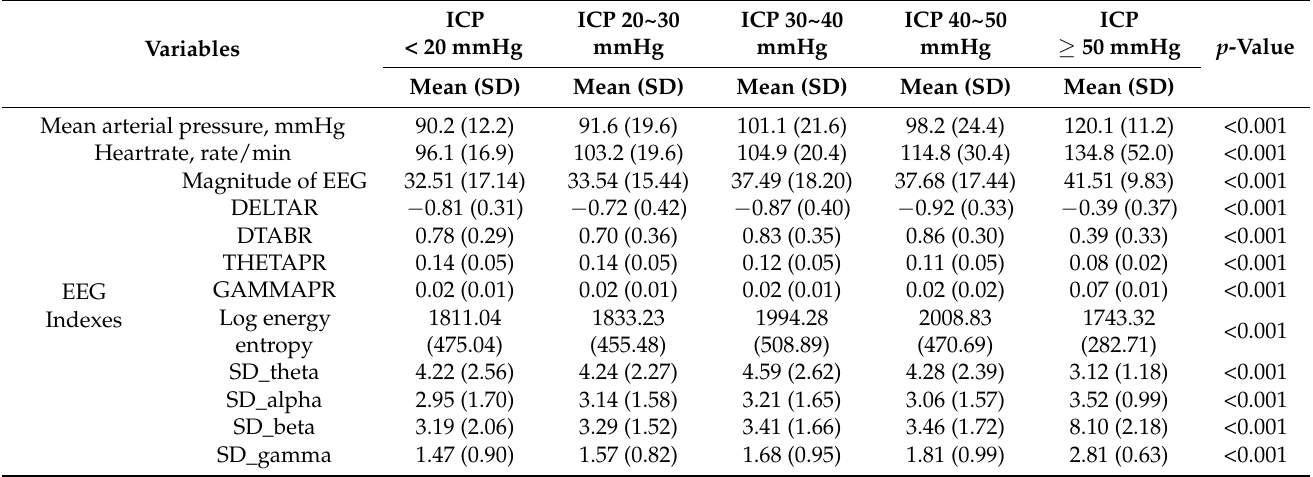
Table 2. Characteristics of electroencephalography parameters in the derivation group according to increased intracranial